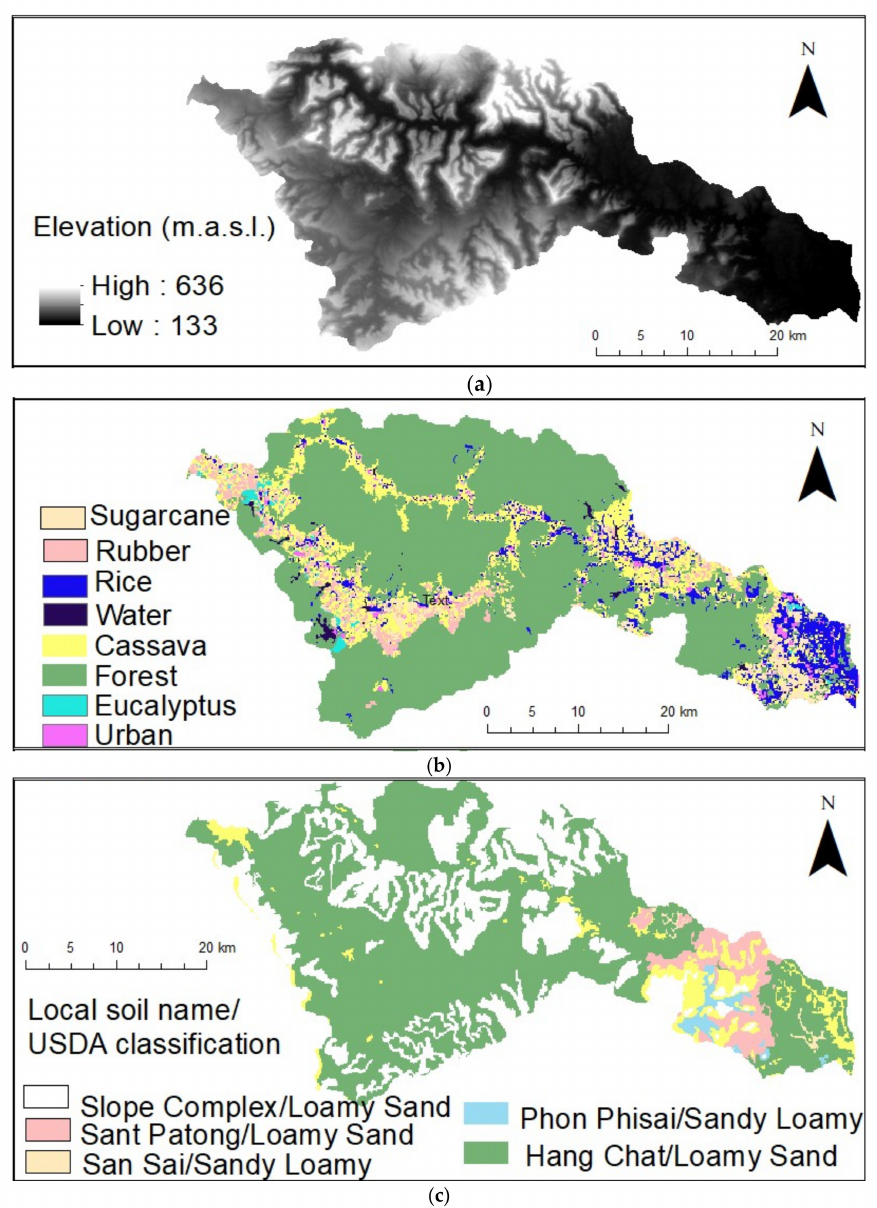
Figure 2. Details of the HBS watershed ( a ) Digital elevation model; ( b ) Land-use patterns; ( c ) Soil